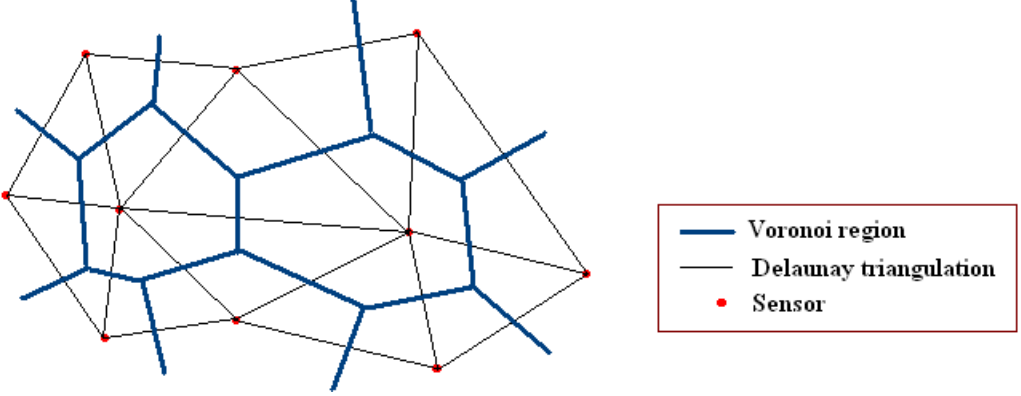
Figure 5. Voronoi regions and corresponding Delaunay triangulation.